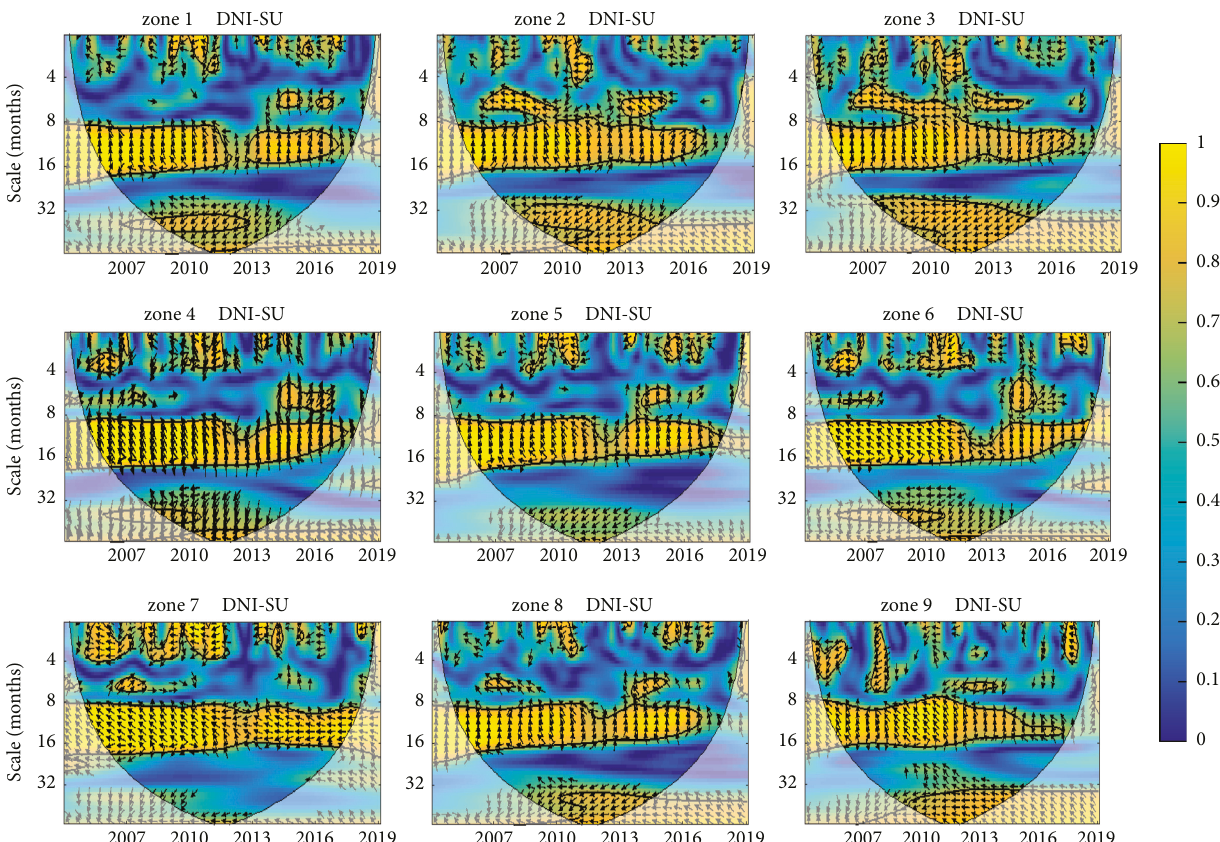
Figure 6: Wavelet coherence between the monthly average of DNI and SU time series (2005–2019). Areas of statistical significance are circled in black; the area outside the cone of influence has no statistical significance. SU and DNI in phase if arrows are pointed to right and out of phase